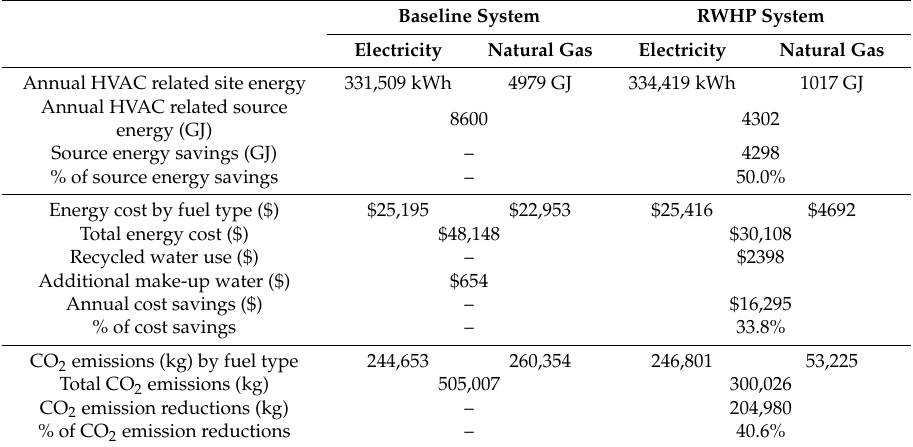
Table 3. Comparison of annual performance between baseline and recycled water heat pump (RWHP)